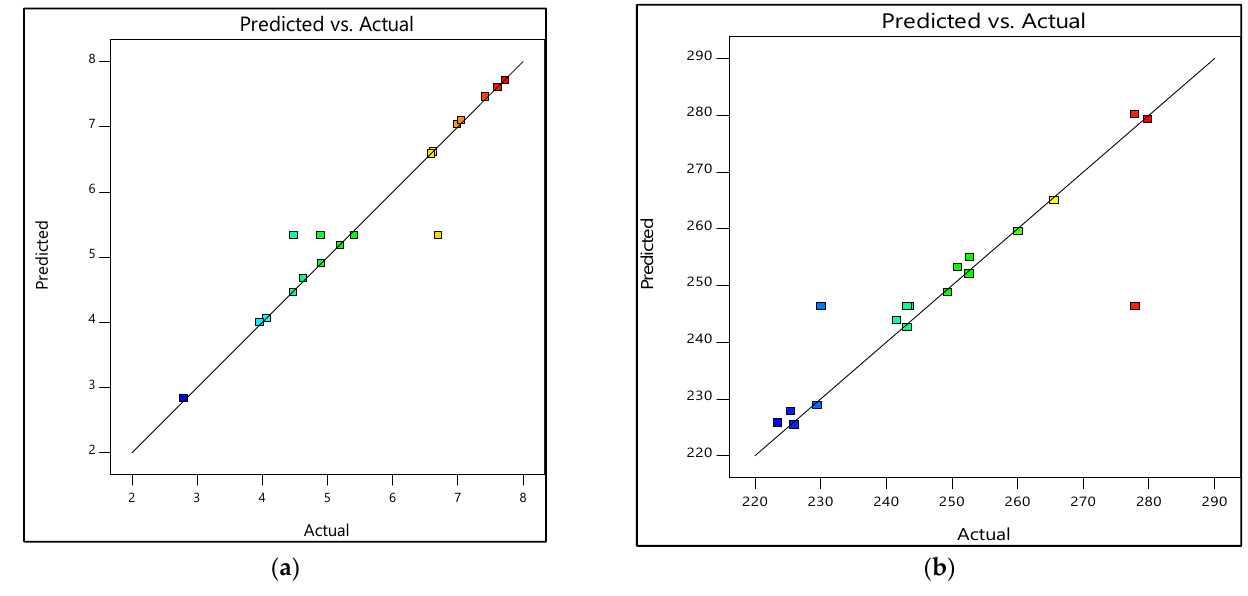
Figure 9. Prediction versus actual graphs for experimental designs of 0% and 100% water: ( a ) Tensile strength, ( b ) Young’s modulus. Predicted vs. Actual